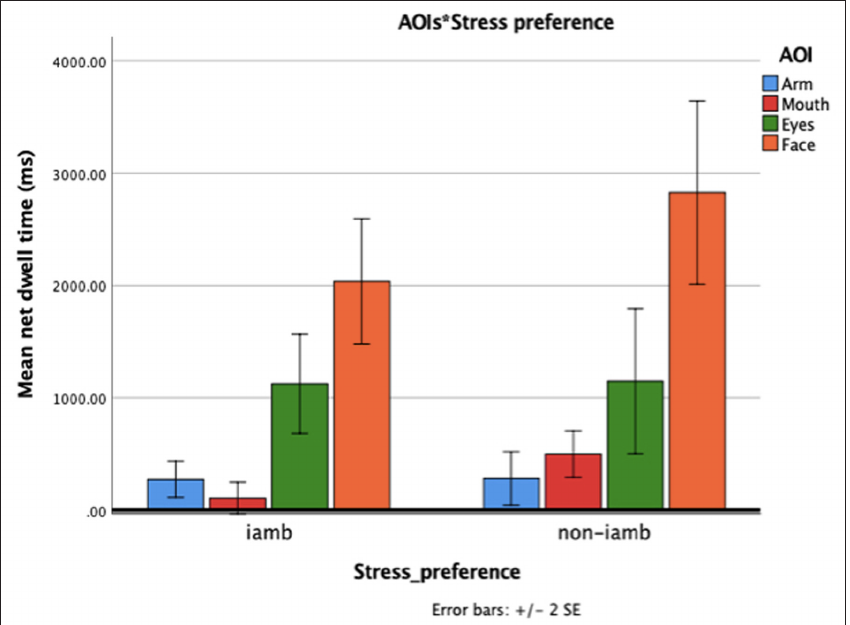
Figure 3: Net dwell time per AOI (arm, mouth, eyes, face) by stress pattern preference (iamb and